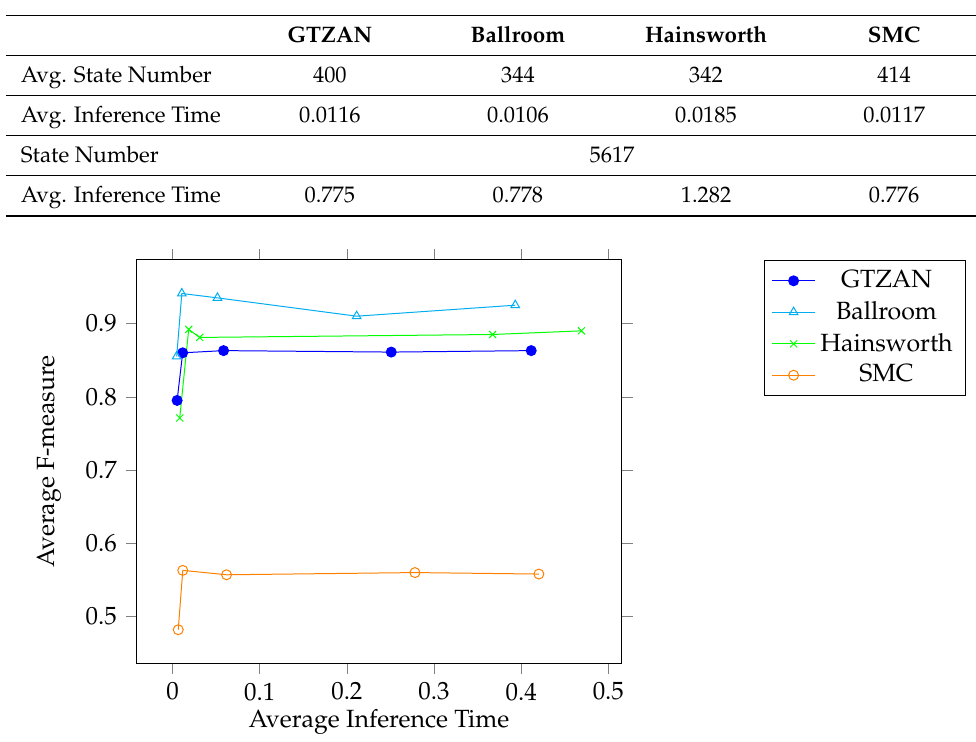
Table 4. The average state number and inference time of the proposed model compared with baseline model. The upper two rows are the results of the proposed model with k = 5, and the lower two rows the baseline model.